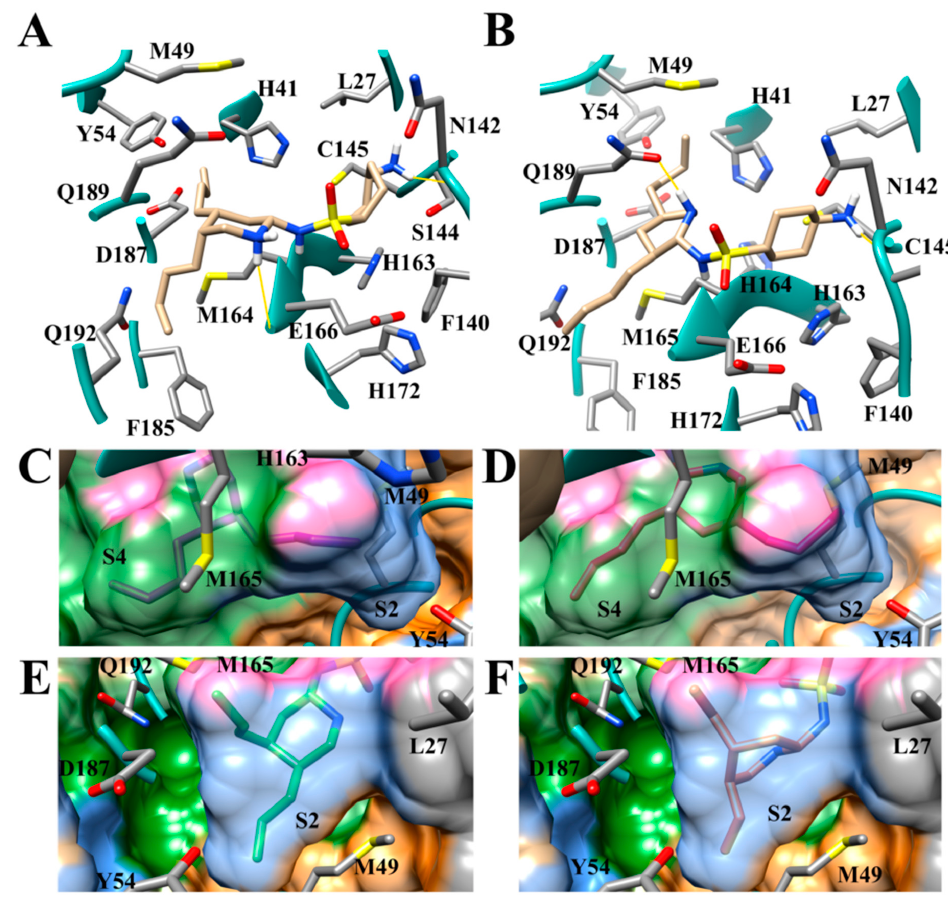
Figure 12. Modes of binding of SFY derivatives. ( A ) SD34 (tan); ( B ) LEA4 (tan); ( C ) SD34 (purple); ( D ) LEA4 (pink); ( E ) SD35 (light green); ( F ) SD36 (brown). In panels ( A ) and ( B ) it can be seen that the aliphatic tails bind in the S2 and the S4 subsites. In panels ( C) through ( F ) of the surface of the subsites, each of the bound aliphatic substituents is shown. The S2 subsite is colored blue, and the S4 subsite is green. Grey regions are portions of the S1 ′ subsite. Hydrogen bonds are indicated by solid yellow lines.